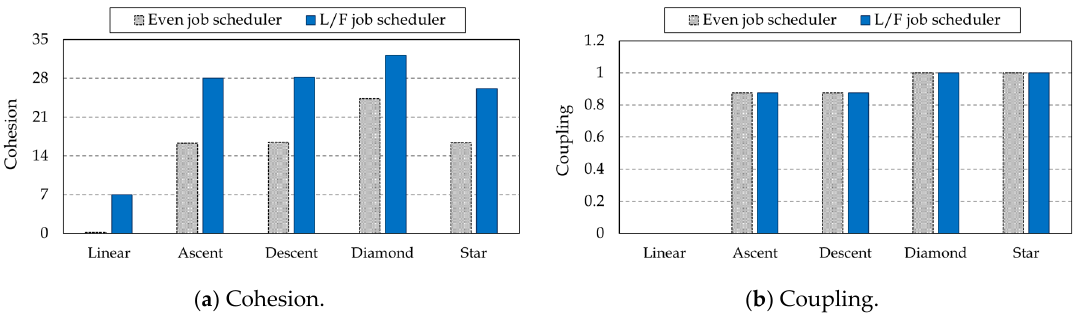
Figure 6. Cohesion and coupling of even and L/F job schedulers.